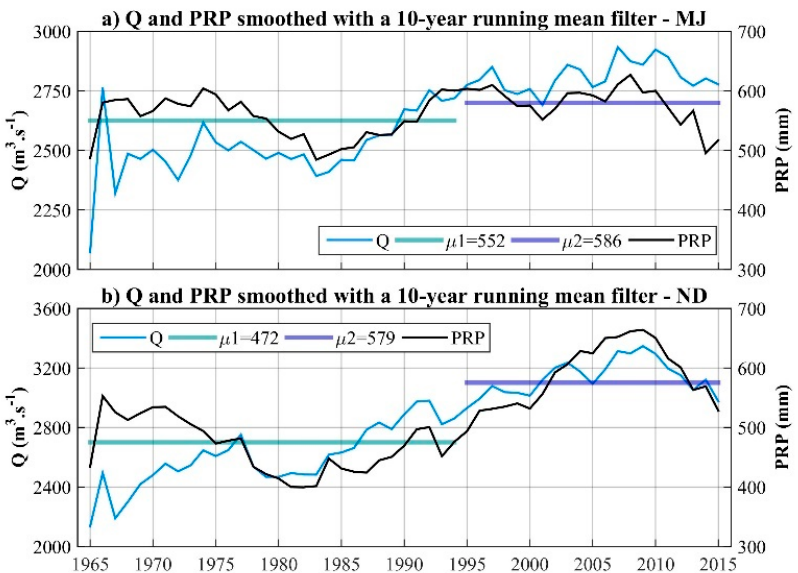
Figure 4. Time series of streamflow (Q) in m 3 · s − 1 and precipitation (PRP) in mm smoothed with a 10-year running mean filter in ( a ) May–June (MJ) and (b) November–December (ND) during the 1965–2015 period. The horizontal blue and purple lines indicate the average precipitation before and after 1994, respectively.